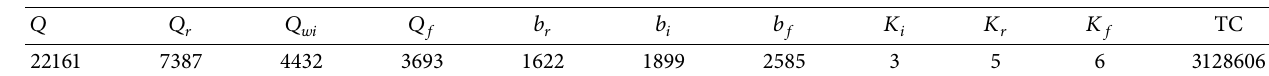
Table 3: Solution